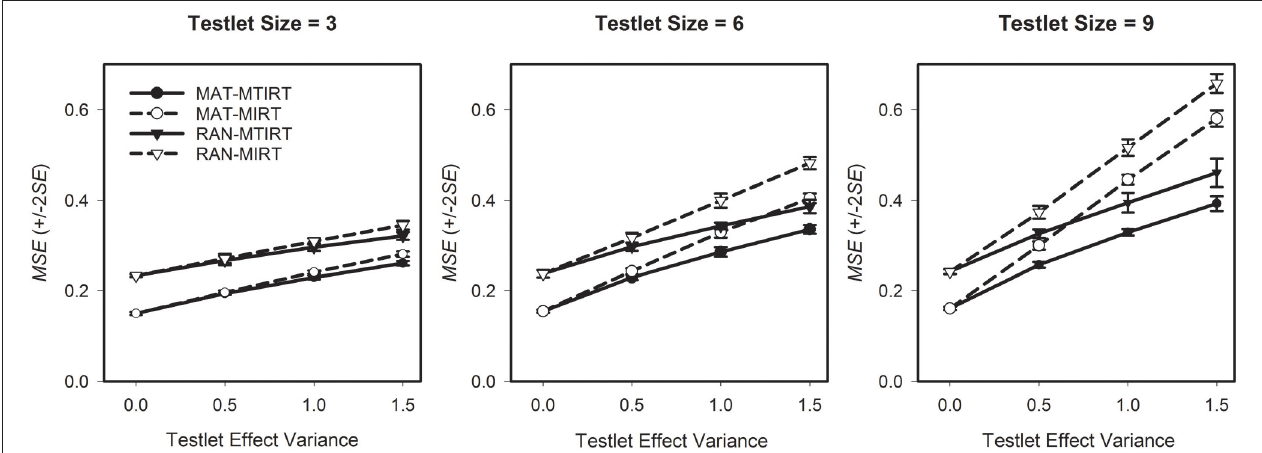
FIGURE 4 | Average mean square error ( MSE ) of the ability estimates for four combinations of testing algorithm and measurement model by testlet effect variance for testlet sizes three, six, and nine.